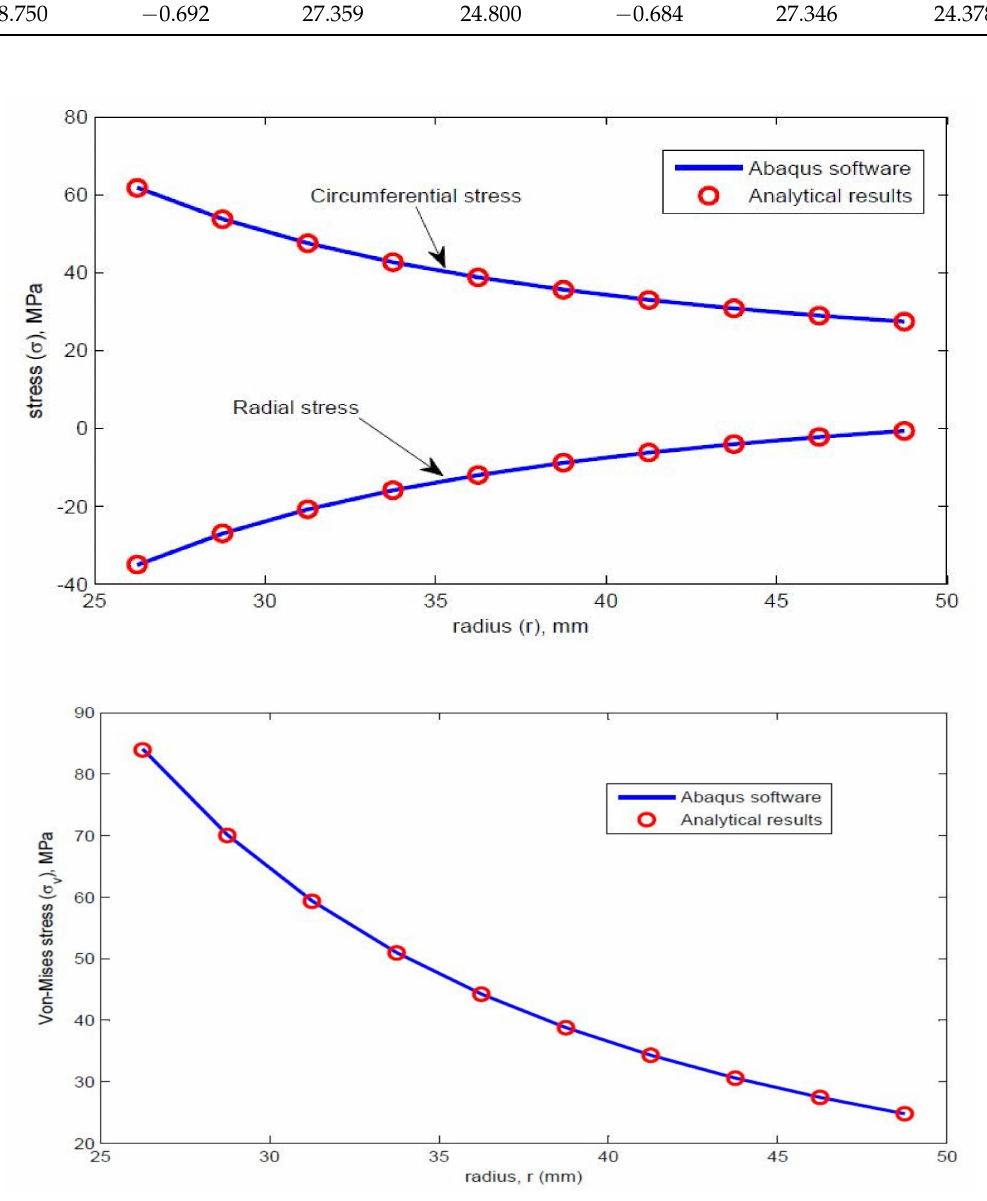
Figure 10. Radial and circumferential stress, and von Mises